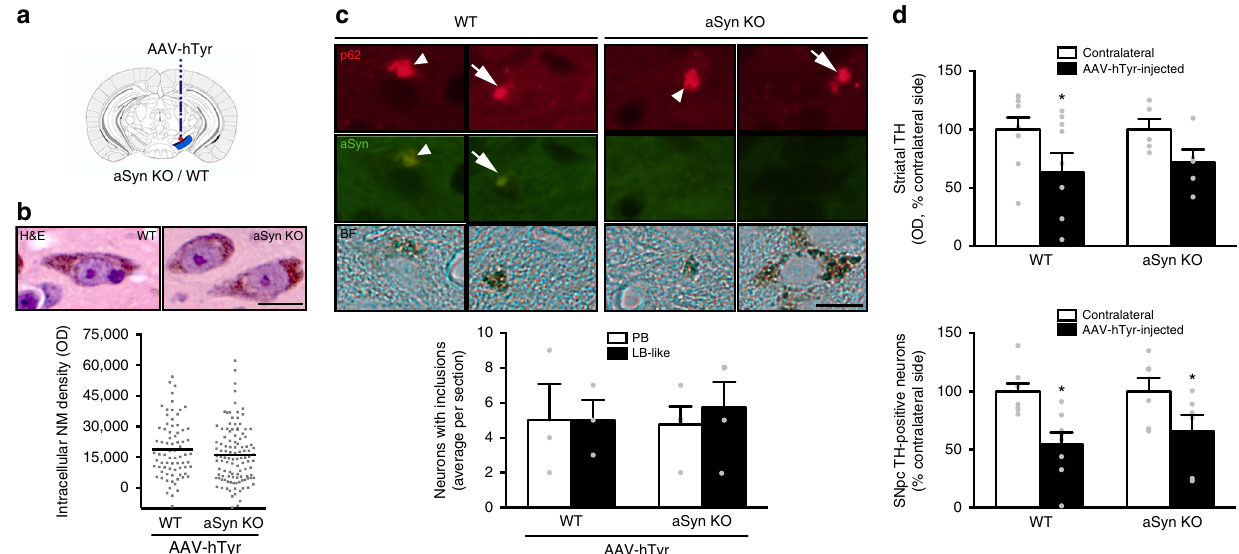
Fig. 7 Dispensability of aSyn for PD-like inclusion formation and neurodegeneration linked to NM accumulation. a Schematic representation of the site of AAV-hTyr unilateral stereotaxic injection above the SNpc of aSyn knockout (KO) and wild-type (WT) mice. b Top, representative photomicrographs of NM-laden neurons in hematoxylin-eosin (H&E)-stained ipsilateral SNpc brain sections from AAV-hTyr-injected aSyn KO and WT mice at 6 m post-AAV injection. Scale bar, 12.5 μ m. Bottom, quanti fi cation of intracellular NM optical density in ipsilateral SNpc DA neurons of AAV-hTyr-injected aSyn KO and WT mice. p = 0.879 (two-tailed t -test). c Top, ipsilateral SNpc sections from AAV-hTyr-injected aSyn KO and WT mice exhibiting NM-laden neurons with p62-positive (red) PB (arrowhead) and LB-like inclusions (arrow) at 2 m post-AAV injection. aSyn immuno fl uorescence is shown in green. Scale bar, 12.5 μ m. Bottom, quanti fi cation of NM-laden neurons with p62-positive PB or LB-like inclusions in AAV-hTyr-injected aSyn KO and WT mice at 2 m post- AAV injection. p = 0.866 (two-way ANOVA). d Top, optical densitometry of striatal TH-positive fi bers in AAV-hTyr-injected aSyn KO and WT mice at 6 m post-AAV injection. * p < 0.05, compared to respective contralateral (non-injected) side (two-way ANOVA; Student – Newman – Keuls post-hoc test). Bottom, stereological cell counts of SNpc TH-positive neurons in AAV-hTyr-injected aSyn KO and WT mice at 6 m post-AAV injection. * p < 0.05, compared to respective contralateral (non-injected) side (two-way ANOVA; Student – Newman – Keuls post-hoc test). In all panels, values are mean ± SEM. In b , n = 76 neurons from n = 4 mice (WT), n = 112 neurons from n = 4 mice (aSyn KO). In c , n = 3 (WT), n = 4 (aSyn KO) mice. In d (top), n = 9 (WT), n